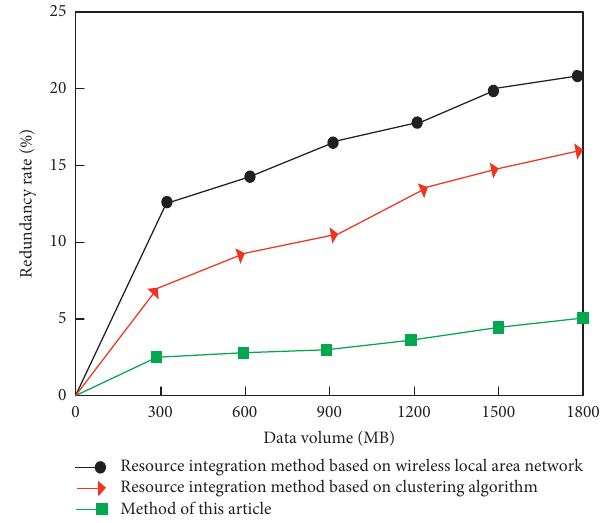
Figure 7: Test results of redundant data volume. Table 2: Comprehensive comparison results/points of resource integration